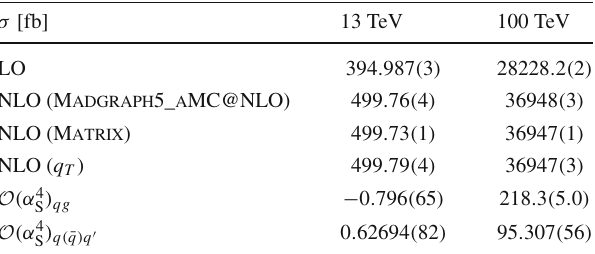
Table 1 The ttH total cross section at LO and NLO, and its NNLO correctionsintheflavouroff-diagonalpartonicchannels.Thenumerical uncertainties at LO and NLO ( Madgraph5_aMC@NLO , Matrix ) are due to numerical integration, while at NLO ( q T subtraction) and NNLO they also include the systematics uncertainty from the r cut → 0